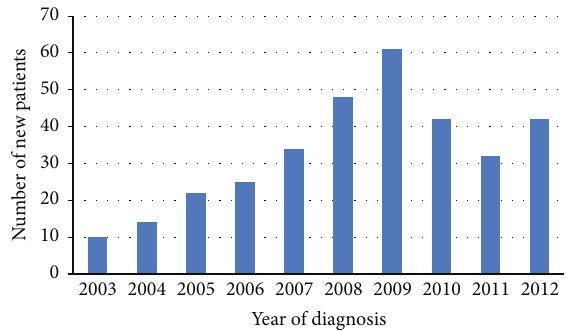
Figure 1: The number of new cases of CD diagnosed each